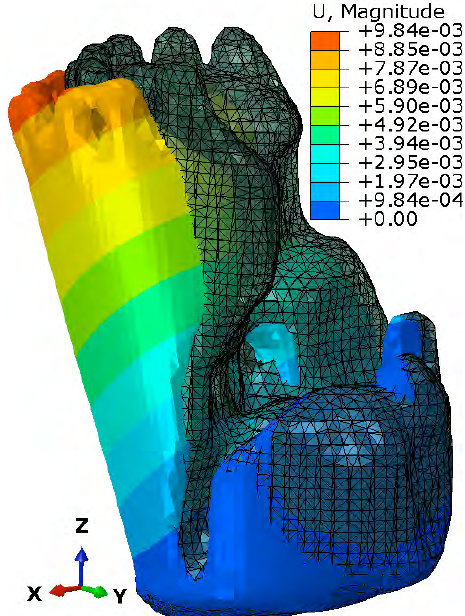
Figure 7. Non-deformed tetrahedral FE volume mesh and dead load linear static analysis: displacement contour plot.